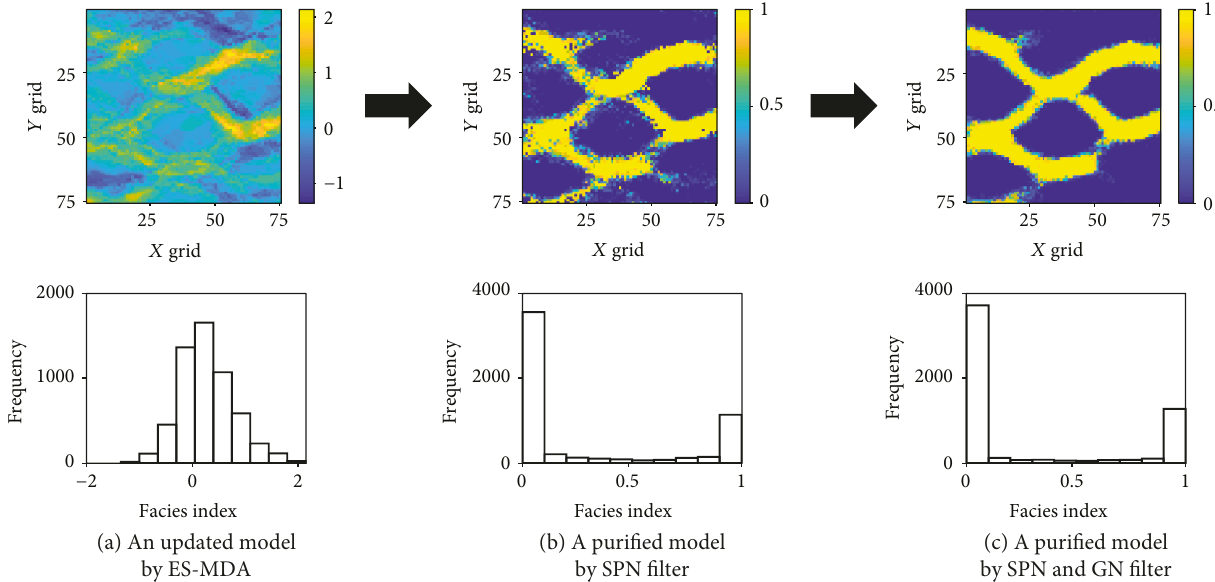
Figure 4: (a) A reservoir realization updated using ES-MDA. (b) A puri fi ed model using a salt and pepper noise (SPN) fi lter. (c) A further puri fi ed model using a Gaussian noise (GN) fi lter on